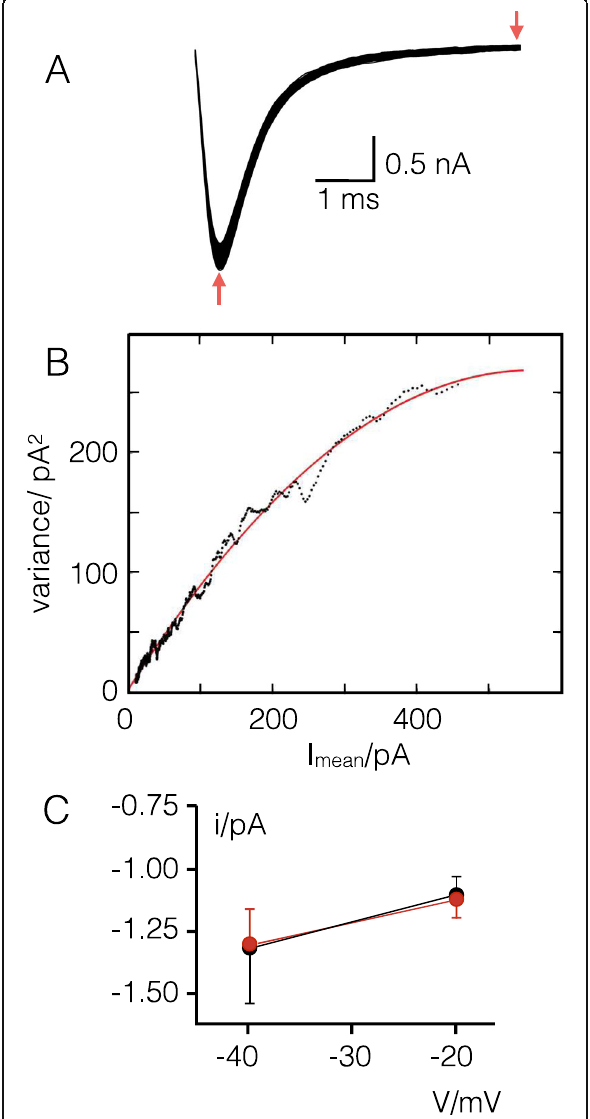
Fig. 4 S106G mutation does not affect unitary channel